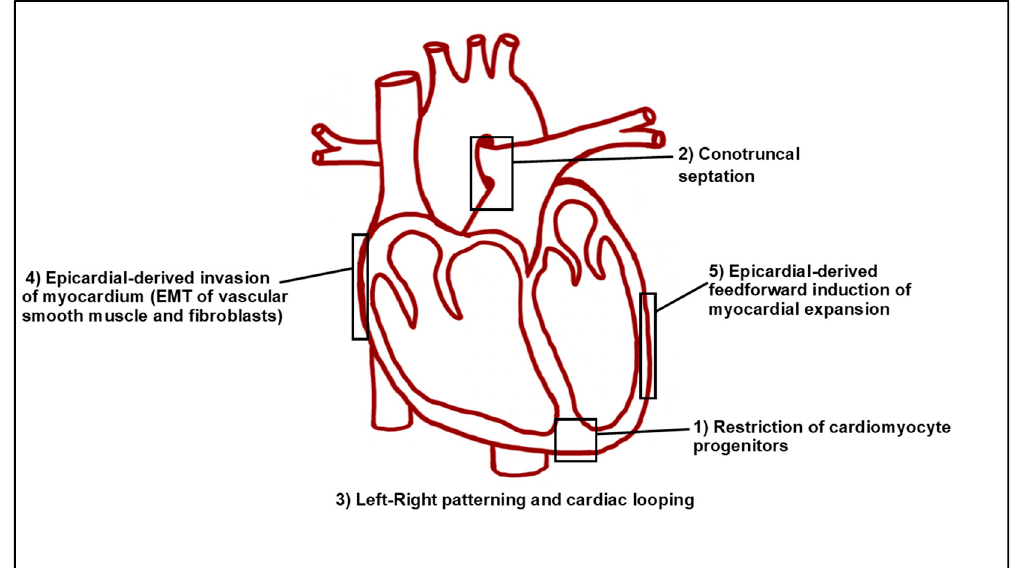
Figure 1. Tightly controlled levels of RA signaling regulate multiple aspects of vertebrate heart development. Schematic of a four ‐ chamber mammalian heart. 1 ) RA restricts the number of CM progenitors during early development within the anterior lateral plate mesoderm (ALPM). 2 ) Multiple levels of RA transport, synthesis, and signaling regulate proper conotruncal septation and the formation of the OFT. 3 ) During the broader processes of cardiac morphogenesis, RA receptors (RARs) have been shown to be crucial for appropriate left ‐ right patterning, cardiac looping, and development of the inflow tract. 4 ) RA is necessary for the proper invasion of epicardial ‐ derived cells into the ventricular myocardium, their subsequent differentiation into fibroblasts, and for the regulation of proper vascular smooth muscle and coronary vessel formation. 5 ) RA also promotes CM proliferation via a feedforward loop that drives its release from the epicardium and is necessary in the epicardium for regeneration.